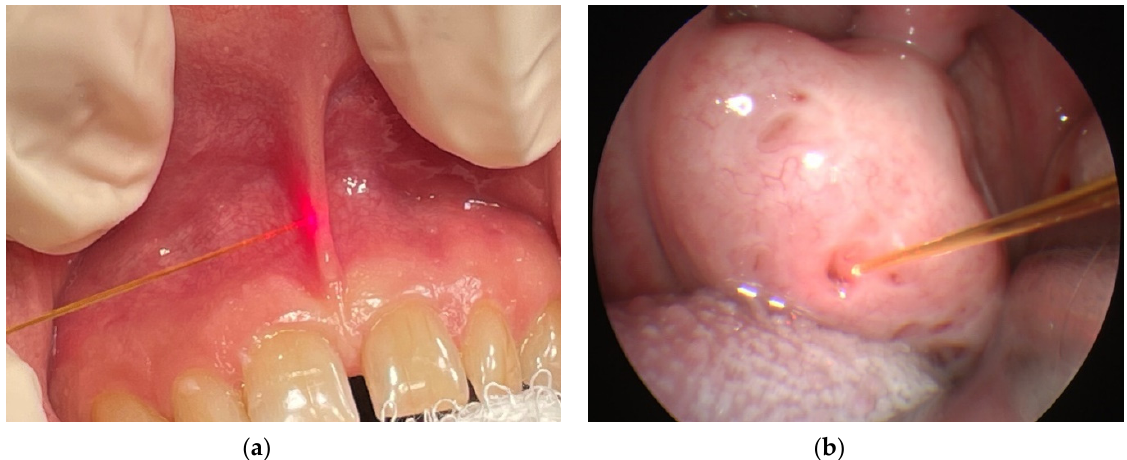
Figure 3. Frenectomy of labial frenulum ( a ) and laser-assisted closure of tonsillar crypts ( b